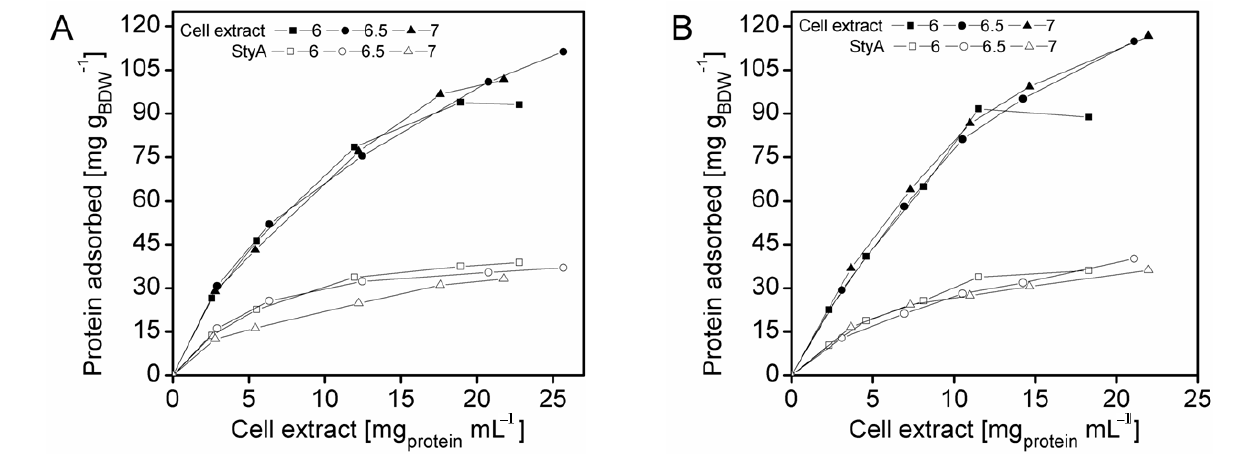
Figure 1. StyA enrichment from Escherichia coli JM101 (pSPZ10) cell extract at various pH values on ( A ) Sepabeads EC-Q1A and ( B ) Sepabeads EC-EA. StyA enrichments reflect the fraction of adsorbed StyA over totally adsorbed Escherichia coli JM101 cell extract proteins at binding